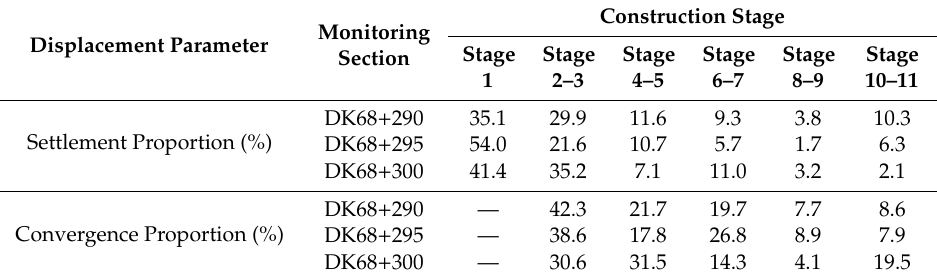
Table 5. Proportion of the tunnel displacement in the di ff erent construction